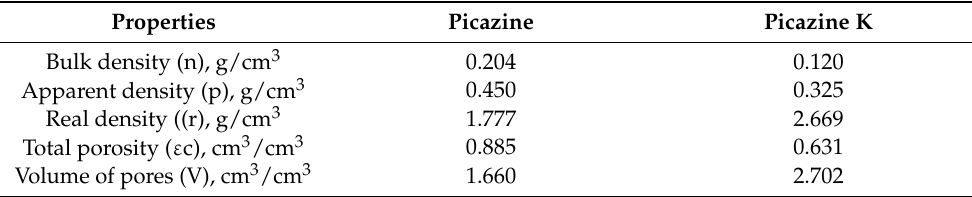
Table 1. Properties of the activated carbons